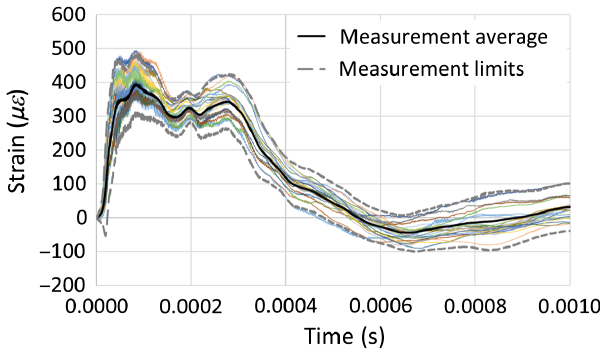
FIG. 9. Tolerance interval calculation of sensor T strain measurement data from T26, T27, and